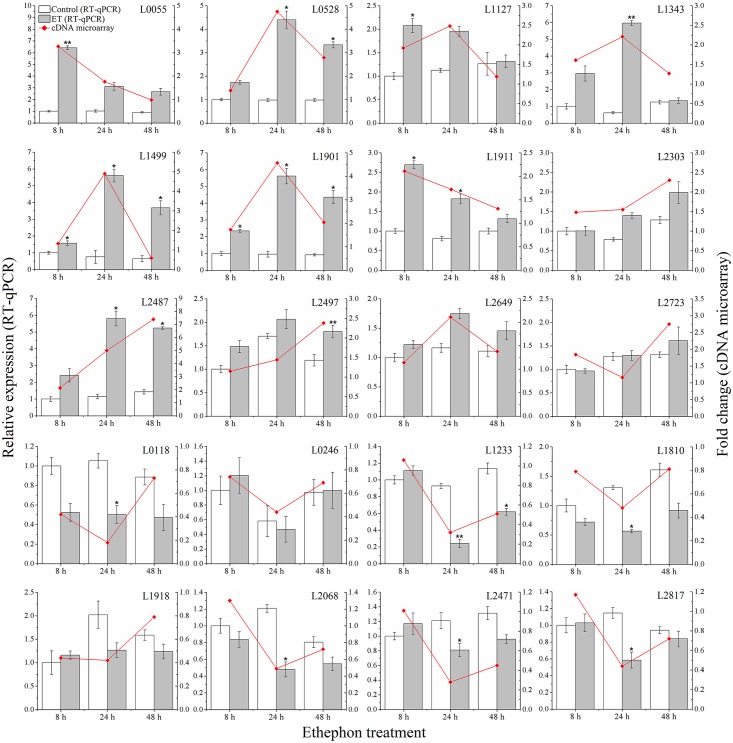
Validation of cDNA microarray data using RT-qPCR.The RT-qPCR analysis was performed as described in ‘Materials and methods’. The transcript abundance of each gene was determined by RT-qPCR and the values were shown as the mean ± standard deviation (n = 3). Statistical significance was determined by Student’s t-test using SPSS 19.0 software. Compared with the control, one asterisk showed a significant difference at p < 0.05 and two asterisks at p < 0.01.